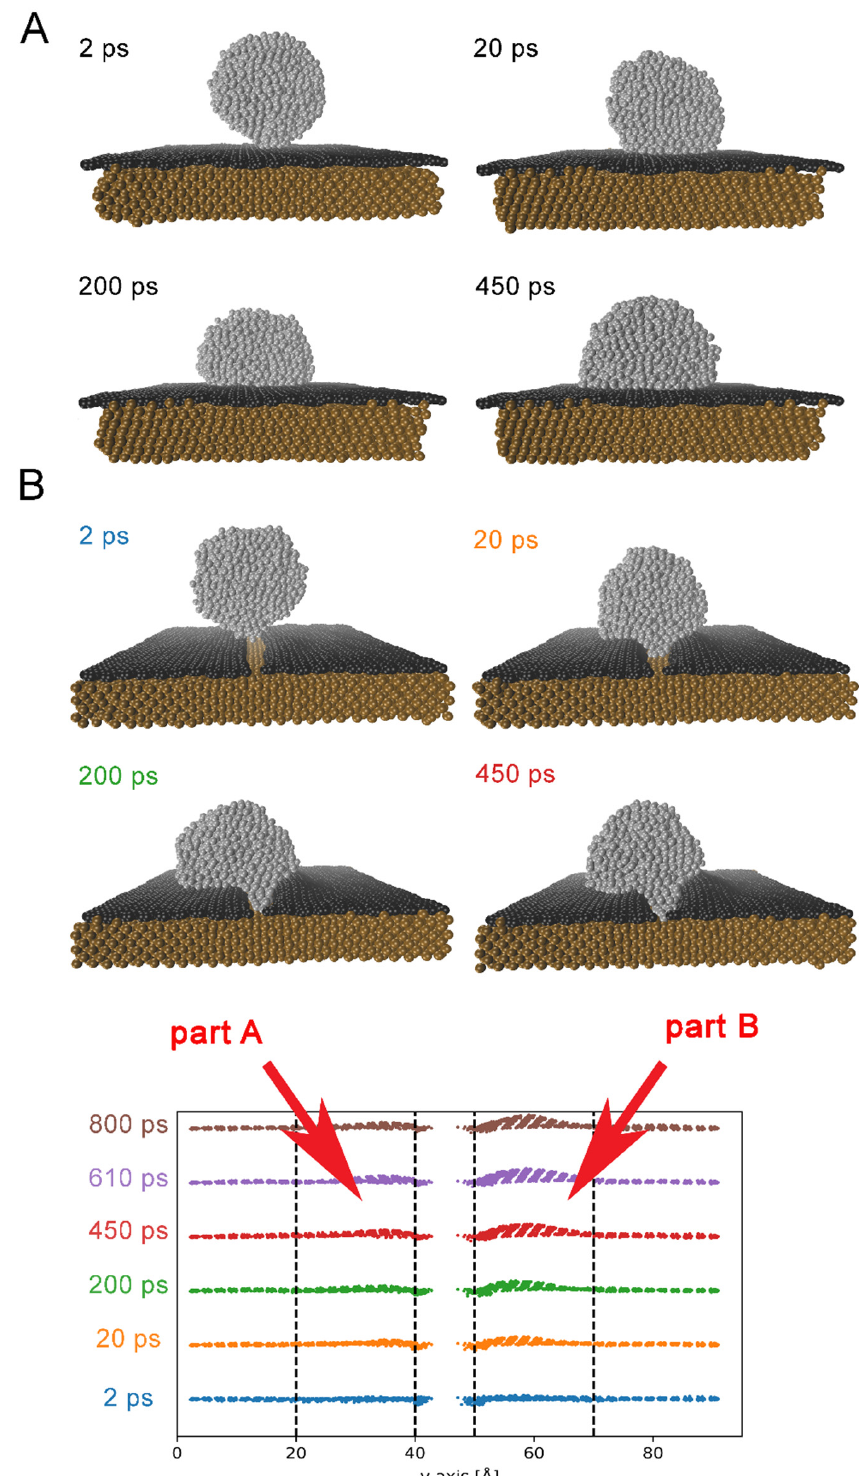
Figure 1. Snapshots taken from MD simulations present wetting phenomenon occurred on ( A ) Cu/Gn substrate and ( B ) Cu/Gn def substrates at 1273 K. Silver, black and orange color represent Ag, graphene and Cu atoms, respectively. Bottom panel presents a time-dependent change of distance between two parts of graphene layer on Cu substrate.